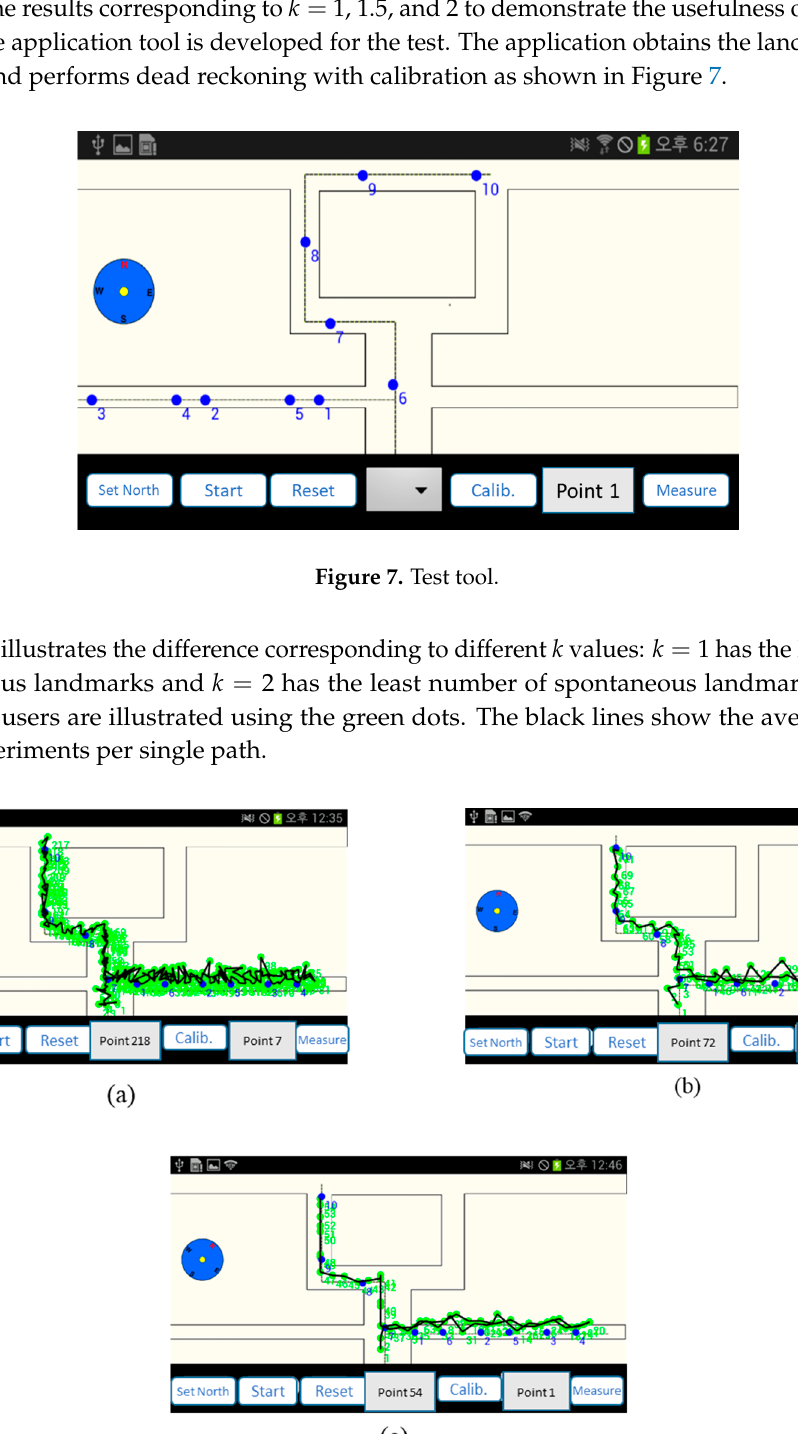
Figure 6. Test floor of small area.